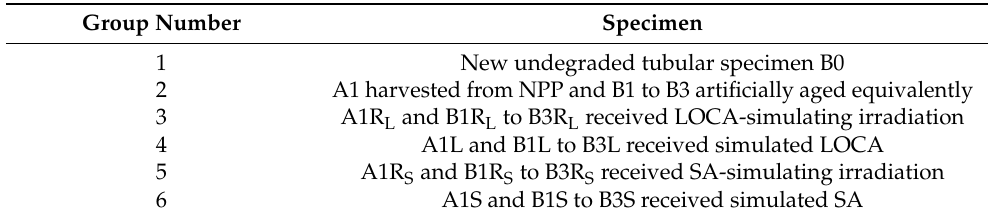
Table 2. Group numbers and the specimens allocated to them. Group Number